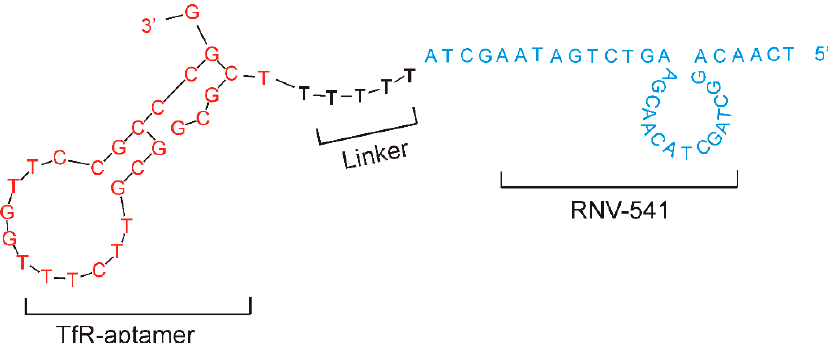
Figure 4. Schematic illustration of TfR aptamer-RNV541 antimiRzyme chimera . The chimeric structure consisted of TfR aptamer (red) and RNV-541 DNAzyme (blue) sections, which were jointed via a d(TTTTT) linker.